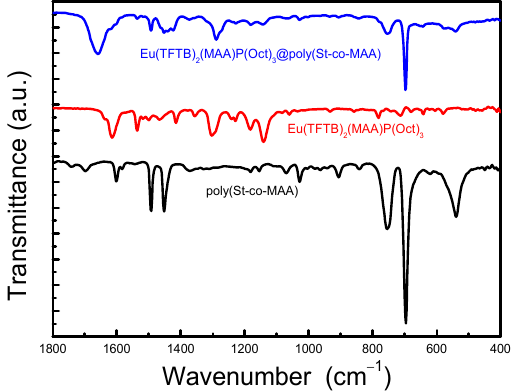
Figure 4. FTIR transmittance spectra of poly(St- co -MAA), Eu(TFTB) 2 (MAA)P(Oct) 3 and Eu(TFTB) 2 (MAA)P(Oct) 3 @poly(St- co -MAA). The peaks at 1413 and 1354 cm − 1 can be assigned to ν (C=C, C=S). CF 3 appeared in TFTB vibration peaks at 1302 cm − 1 ( ν (CF 3 )) and 716 cm − 1 ( δ (CF 3 )). The peak at1536 cm -1 ( ν (C=O)) can be assigned to the vibration peak of the keto-enol tautomerization of β - diketone. The peaks at 1060 cm − 1 ( δ (O-CH 3 )) and 857 cm − 1 ( δ (CH 3 )). The peaks at 1695 cm − 1 , 1634 cm − 1 , 1416 cm − 1 , and 1301 cm − 1 correspond to the levels of C=O, C=C, –CH 2 and -CH 3 coming from